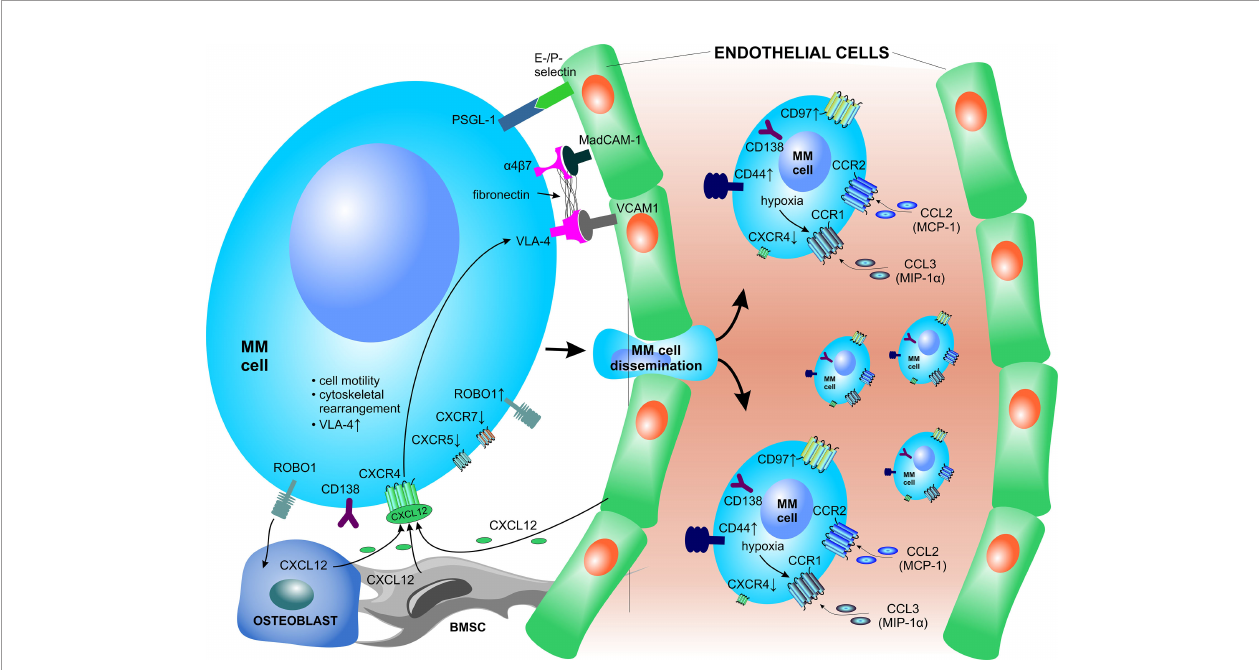
FIGURE 3 | Crucial factors involved in bone marrow homing of plasma cells. PCs express several surface receptors which serve as environmental sensors but are also crucial for interactions with vascular structures and other components of the BM niche. The homing, lodging and retention of PCs to the BM is primarily mediated via the CXCL12 – CXCR4 signaling axis. BMSC, bone marrow stromal cell; CCL, C-C motif chemokine ligand CCR, C-C motif chemokine receptor; CXCL, C-X-C motif chemokine ligand; CXCR, C-X-C motif chemokine receptor; MAdCAM-1, mucosal vascular addressin cell adhesion molecule 1; MCP-1, monocyte chemoattractant protein-1; MIP-1 a , macrophage in fl ammatory protein 1- a ; MM, multiple myeloma; PSGL-1, P-selectin glycoprotein ligand-1; ROBO1, roundabout guidance receptor 1; VCAM1, vascular cell adhesion molecule 1; VLA-4, very late